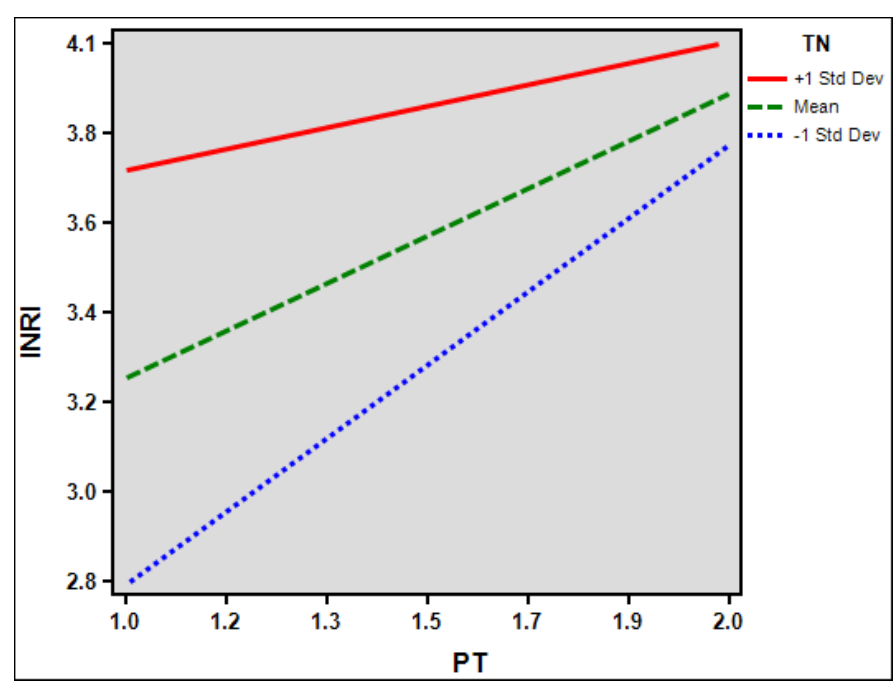
Figure 2. The plot of the interaction effect of team norm on the relationship